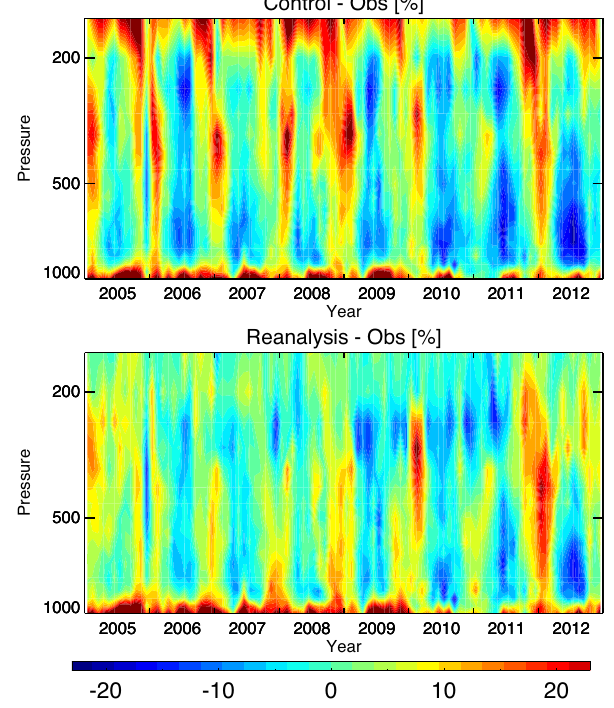
Figure 6. Vertical profiles of the time series of the monthly mean O 3 concentration difference (in %) between the control run and ozonesondes (top) and between the reanalysis and ozonesondes (bottom) averaged over the NH mid-latitudes (15–55 ◦ N).